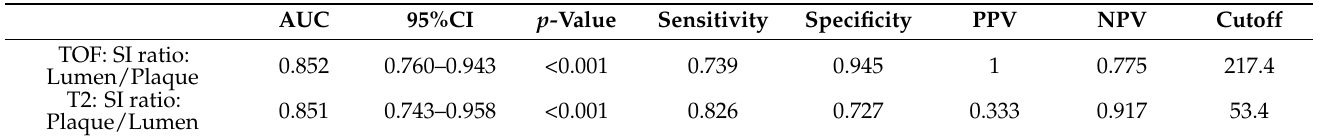
Table 3. ROC curve analysis of signal intensity ratio between both groups.